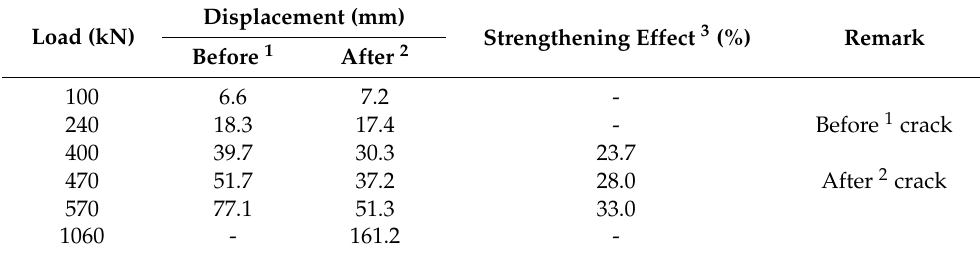
Table 4. Comparison of displacement before and after strengthening.